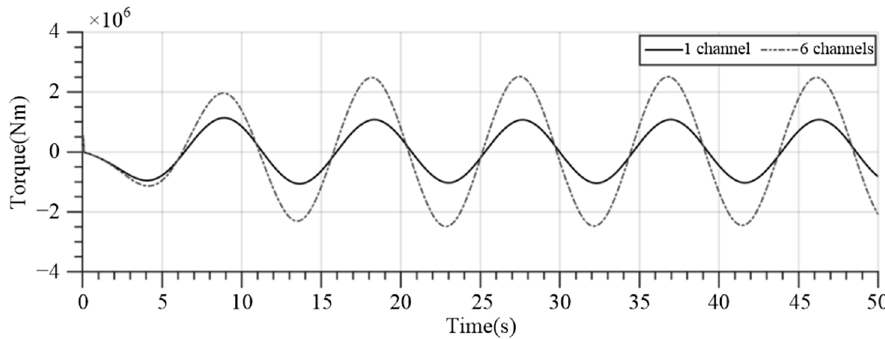
Figure 8. Forced oscillation curves with 1 channel and 6 channels.